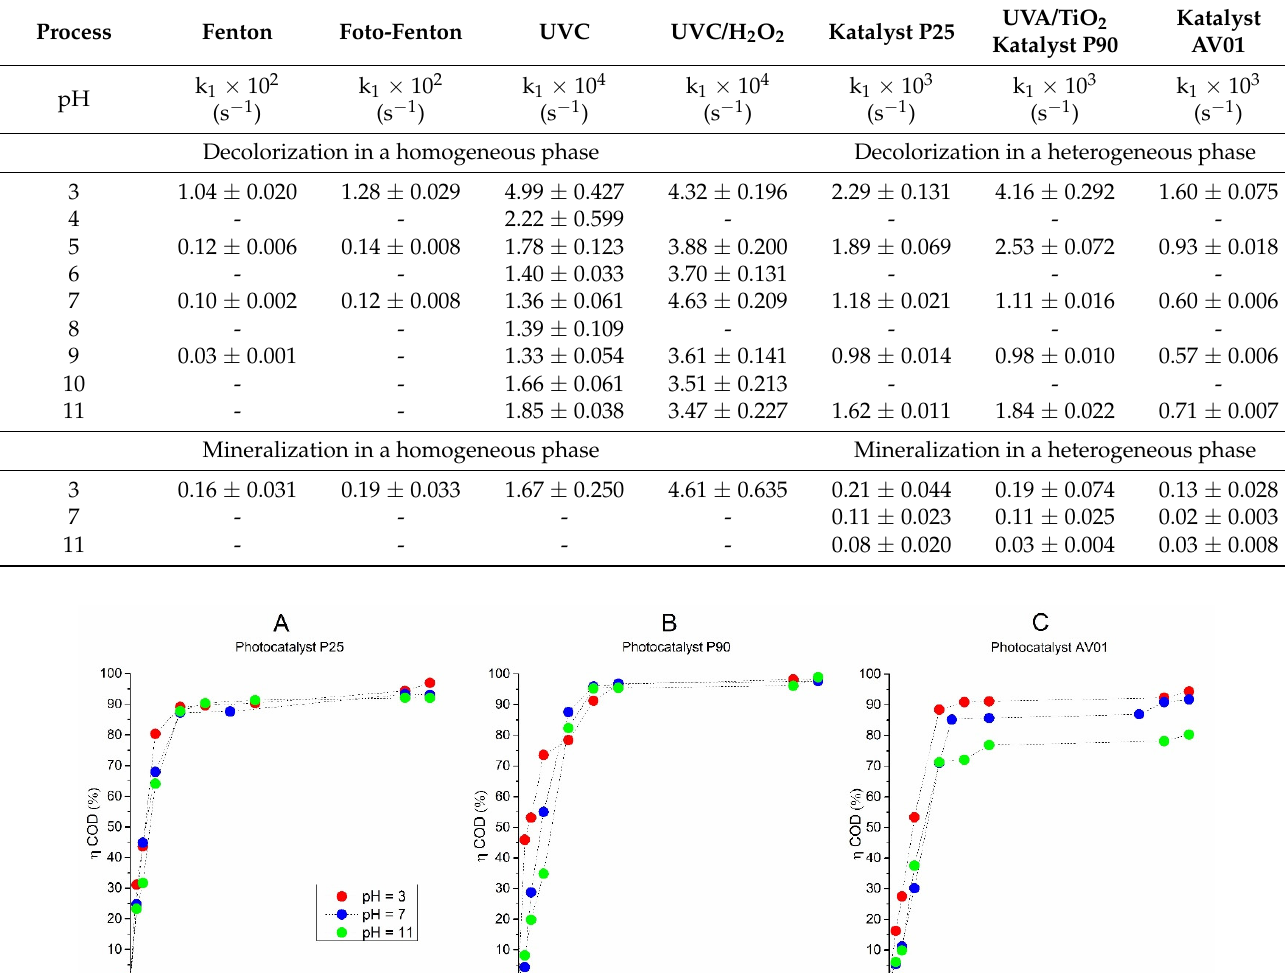
Table 2. Overview of the rate constants of the pseudo-first-order for AB80 decolorization and mineralization, depending on pH of the environment for various reaction systems at t = 25 ◦ C.